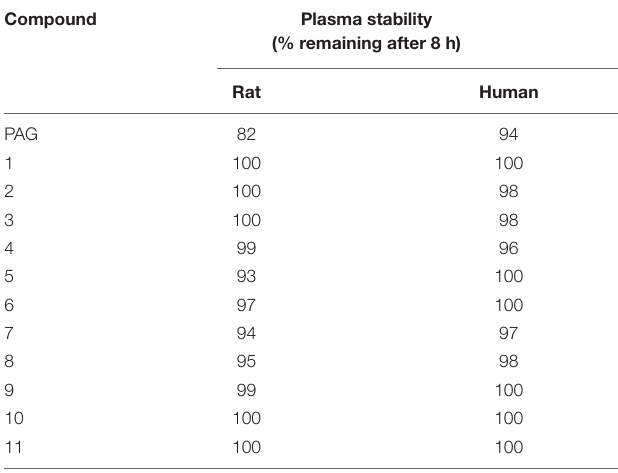
TABLE 5 | Stability of compounds PAG, 1–11 in rat and human plasma a . Compound Plasma stability (% remaining after 8